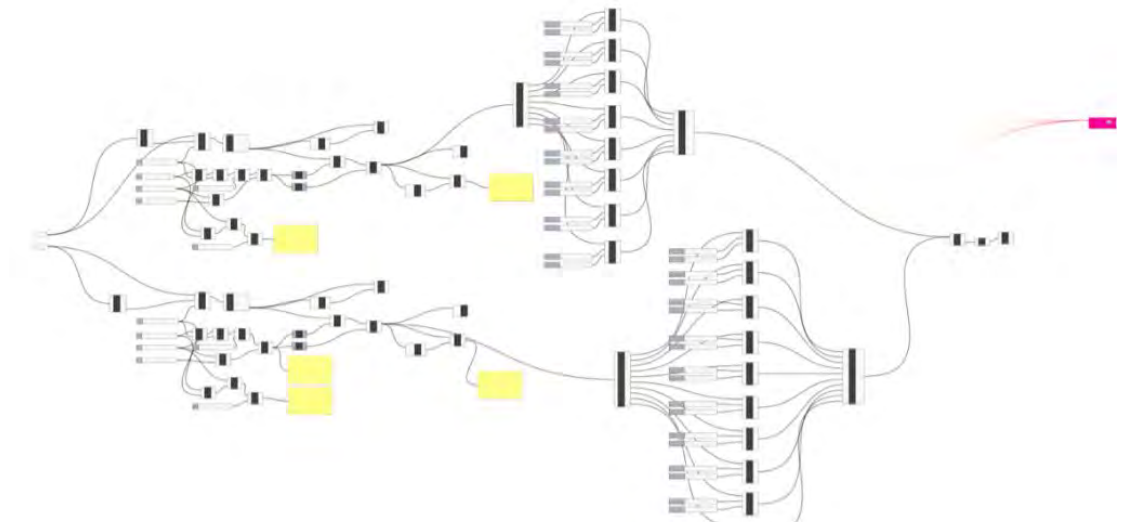
Figure 9. Script of connectivity optimizing